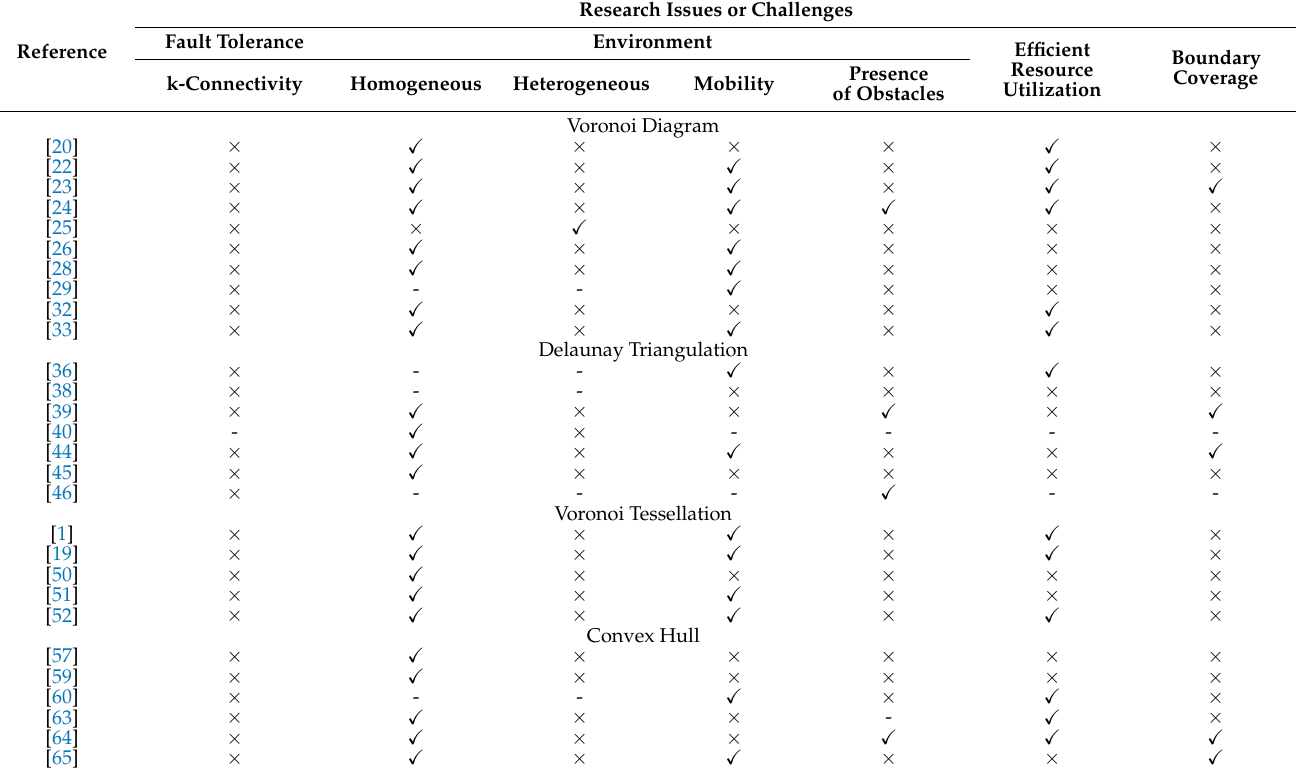
Table 7. The research issues/challenges covered or not covered (limitations) by various